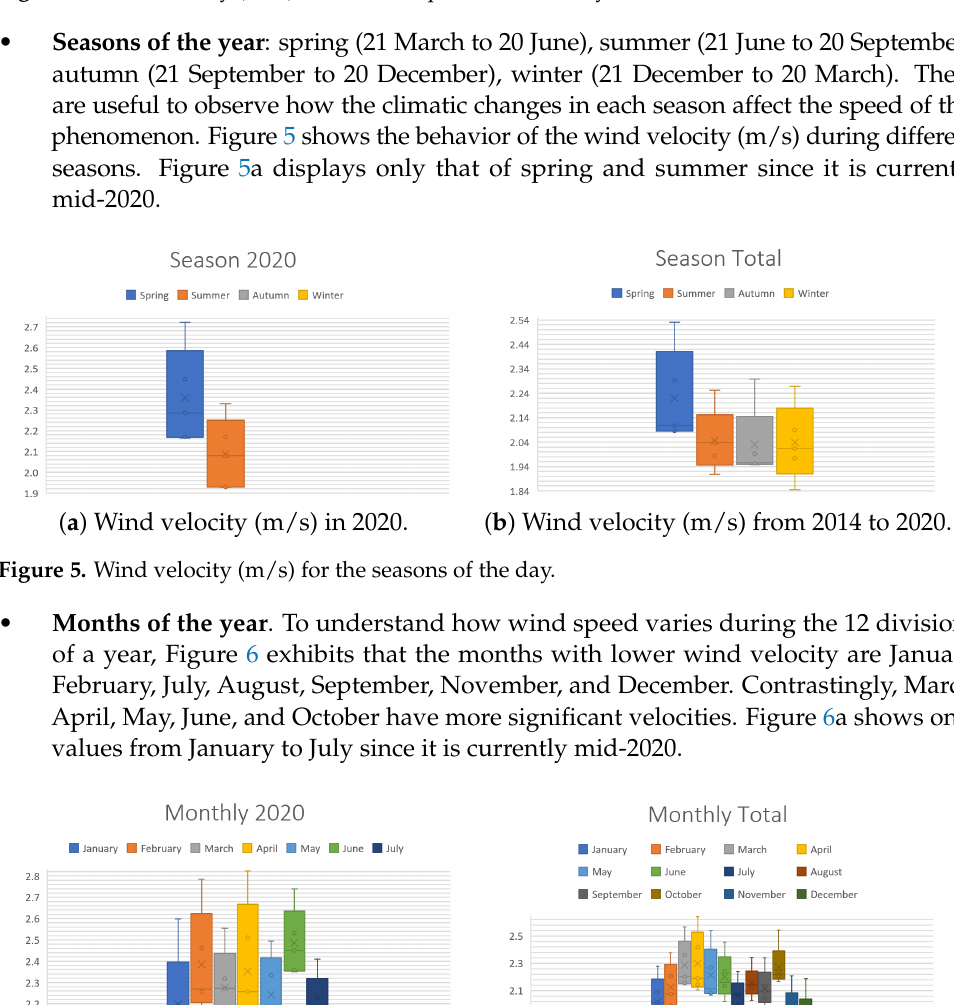
Figure 4. Wind velocity (m/s) for the three periods of the day.